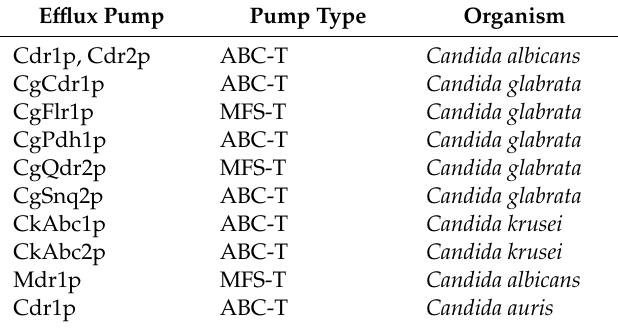
Table 1. List of known multi-drug resistance-causing e ffl ux